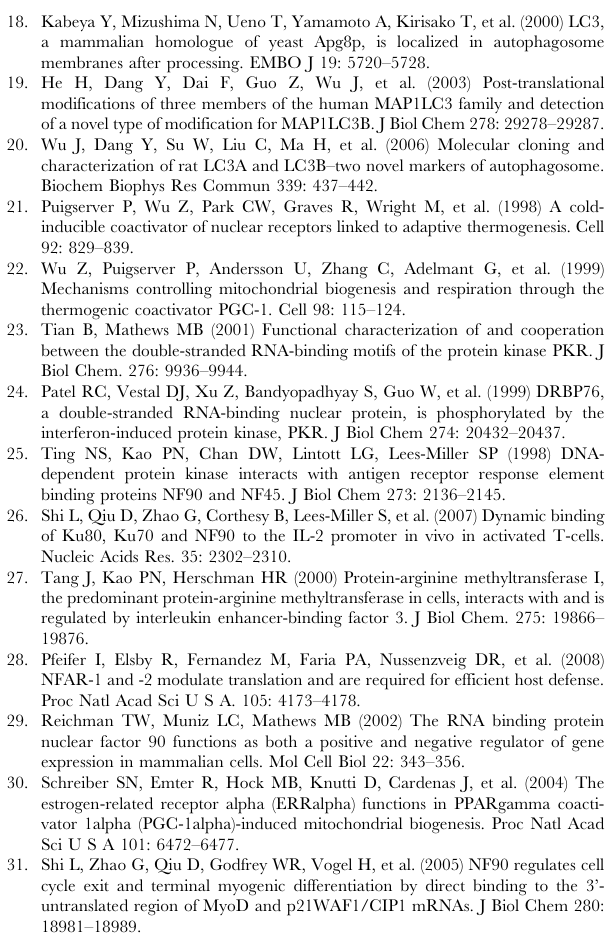
and adrenaline in the plasma of mice are shown in A and B, respectively. All data are expressed as means 6 SD (n =9 per Figure S4 HE-stained sections of cardiac muscle from WT (I to V) and NF90 Tg mice (line TG1) (VI to X) at the age of 6 weeks through 10 weeks. Arrows highlight vacuolations. Scale bars show 10 mm at the inset. (TIFF) Figure S5 Immunoblot analysis of NF90 in cardiac muscle from WT (n= 2) and NF90 Tg mice (line TG1) (n =2) at the age of 6 weeks through 10 weeks, and at 18weeks of age. Anti- a -tubulin was used as loading control. W1 and W2, wild-type; T1-1 and -2, NF90 Tg mice (line TG1). Intensities of specific bands in the immunoblotting analysis were measured with a densitometer and are presented as a graph. (TIFF) Figure S6 Immunoblot analysis of caspase-3 and cas- pase-6 in the skeletal muscles from WT and NF90 Tg mice (lines TG1). Anti- a -tubulin was used as loading control. (TIFF) Figure S7 Immunoblot analysis of NF90 in primary cells of skeletal muscles from WT and NF90 Tg mice